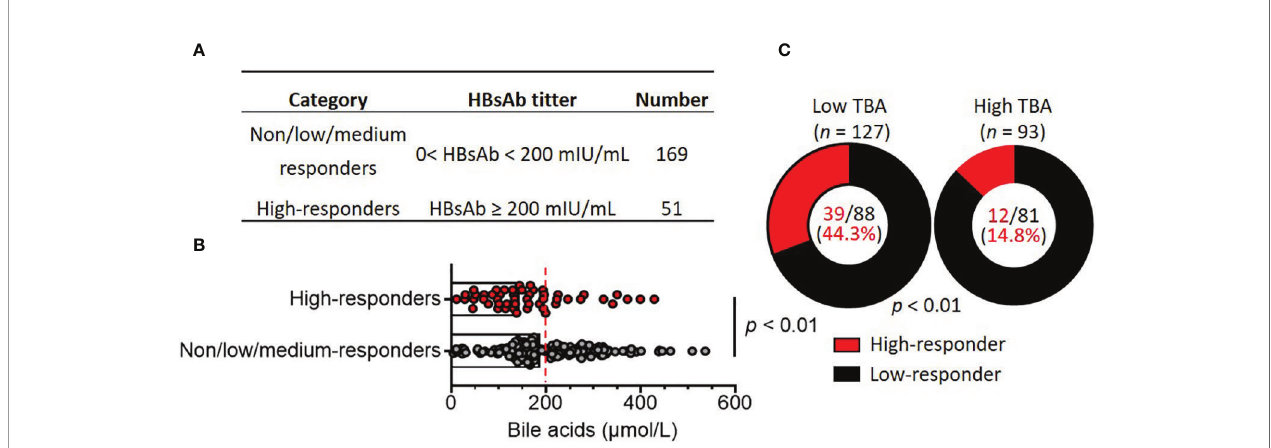
FIGURE 2 | High bile acid levels are associated with poor HBV vaccine responses in patients with biliary atresia. (A) Children with biliary atresia ( n = 220) were classi fi ed as non, low, medium (no/low/medium, Low) responders and high responders based on HBsAb titers after vaccination with the HBV vaccine. (B) Comparison of serum bile acid levels between non/low/medium responders ( n = 169) and high responders ( n = 51). The dotted line indicates subjects with low bile acid levels (0-200 mmol/L) and high bile acid levels ( ≥ 200 mmol/L). (C) Comparison of responder rates between the low bile acid ( n = 127) and high bile acid ( n = 57)